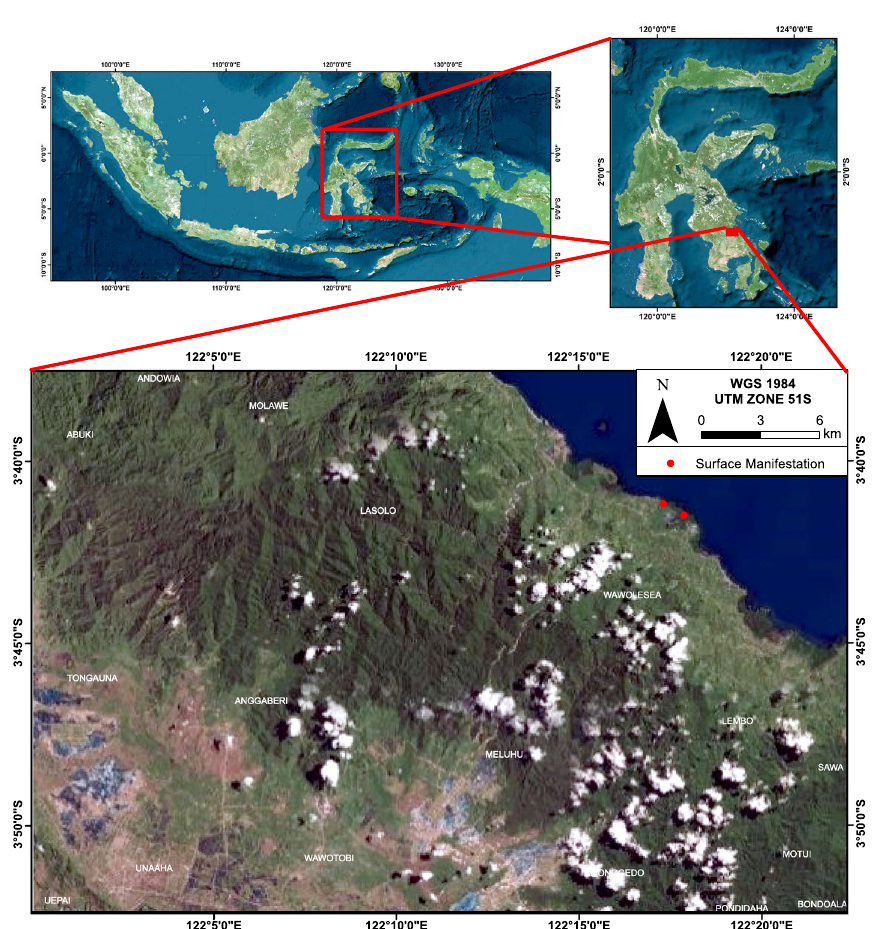
Fig. 1 Microsoft Bing map showing the location of study area in the northern part of Konawe (Data source: Microsoft Bing